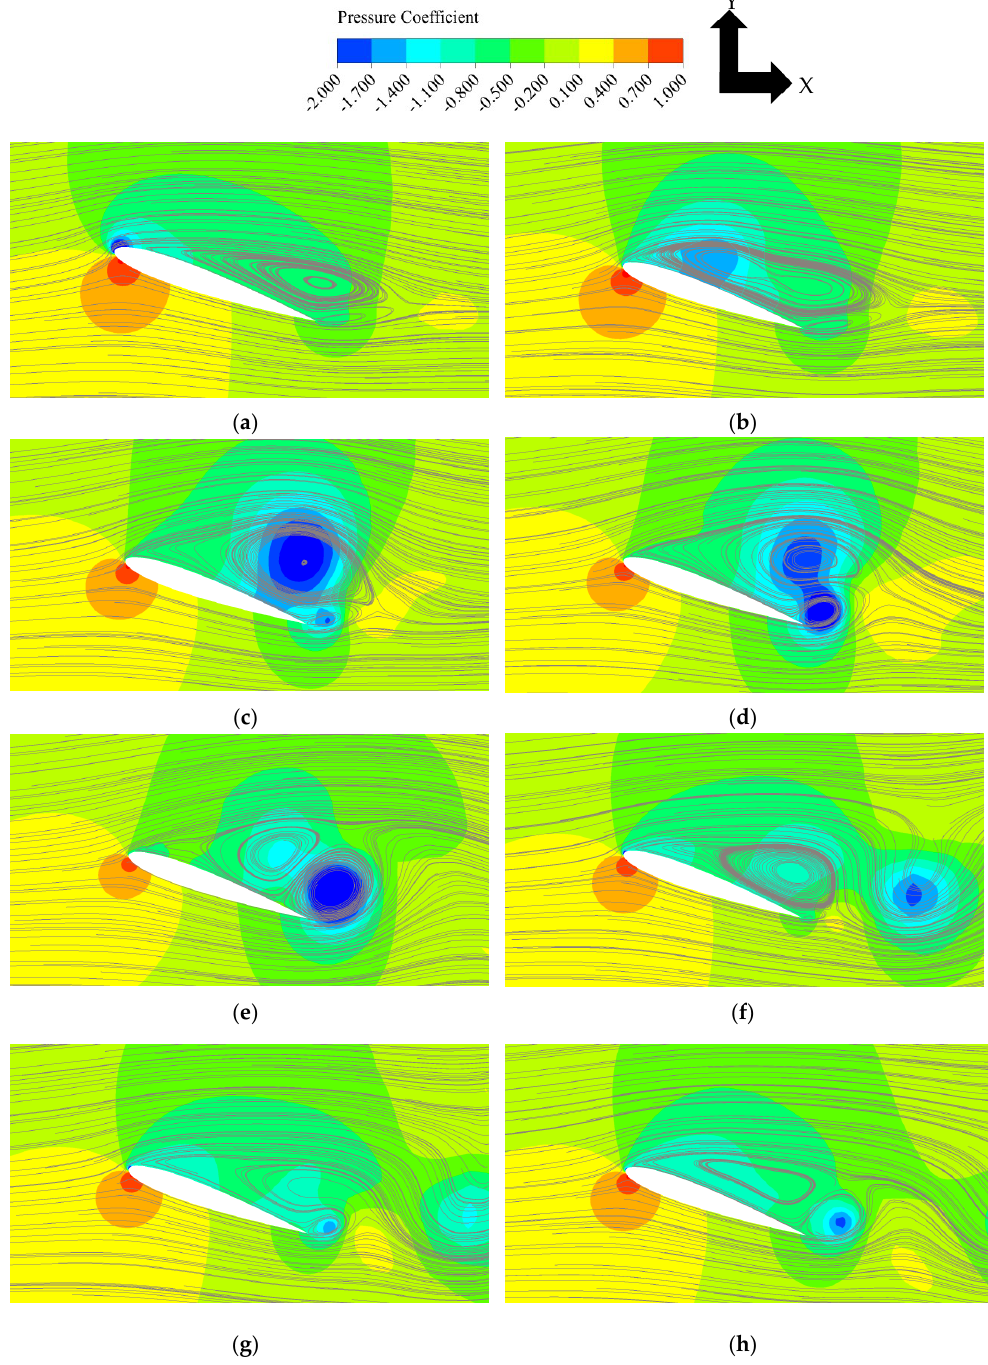
Figure 13. Pressure field and stream lines around the aerofoil. Maximum AoA = 21 ◦ , f = 0.01. ( a ) AoA = 19.13 ◦ ↑ ; ( b ) AoA = 19.27 ◦ ↑ ; ( c ) AoA = 19.41 ◦ ↑ ; ( d ) AoA = 19.46 ◦ ↑ ; ( e ) AoA = 19.55 ◦ ↑ ; ( f ) AoA = 19.67 ◦ ↑ ; ( g ) AoA = 19.72 ◦ ↑ ; ( h ) AoA = 19.76 ◦ ↑